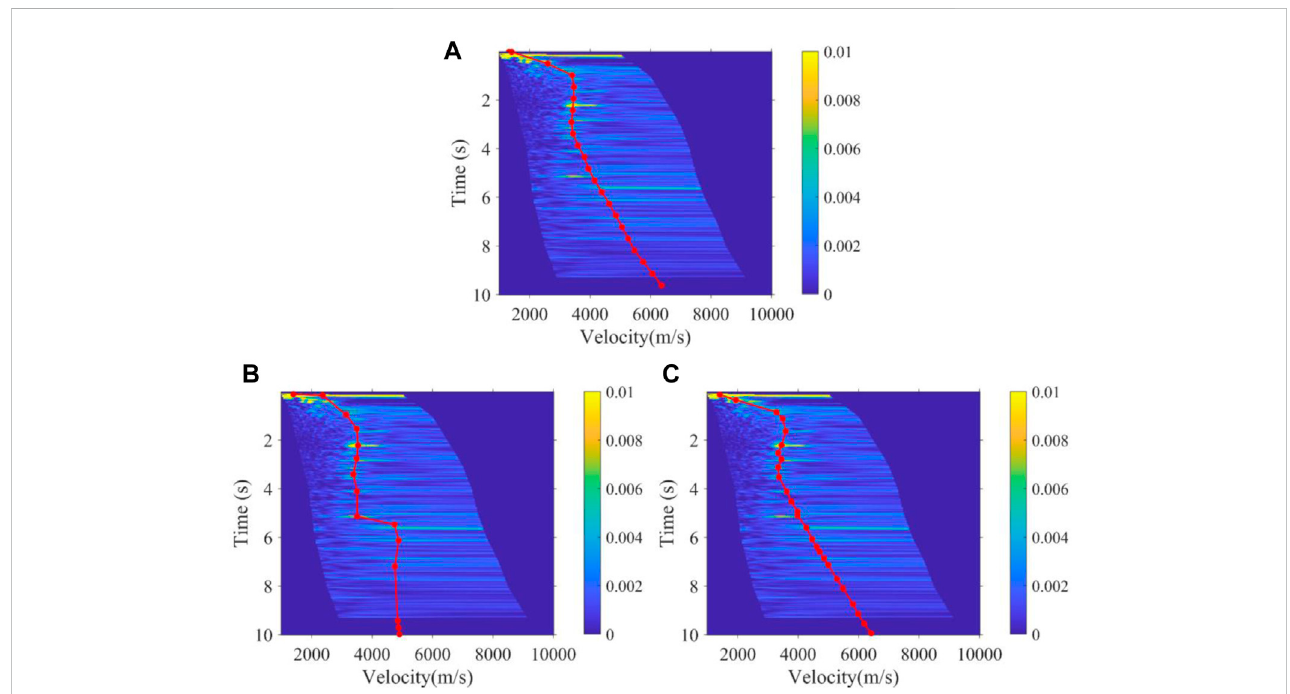
FIGURE 14 Velocity function of the 100th velocity spectrum obtained by (A) manual, (B) K-means, and (C) the method proposed.